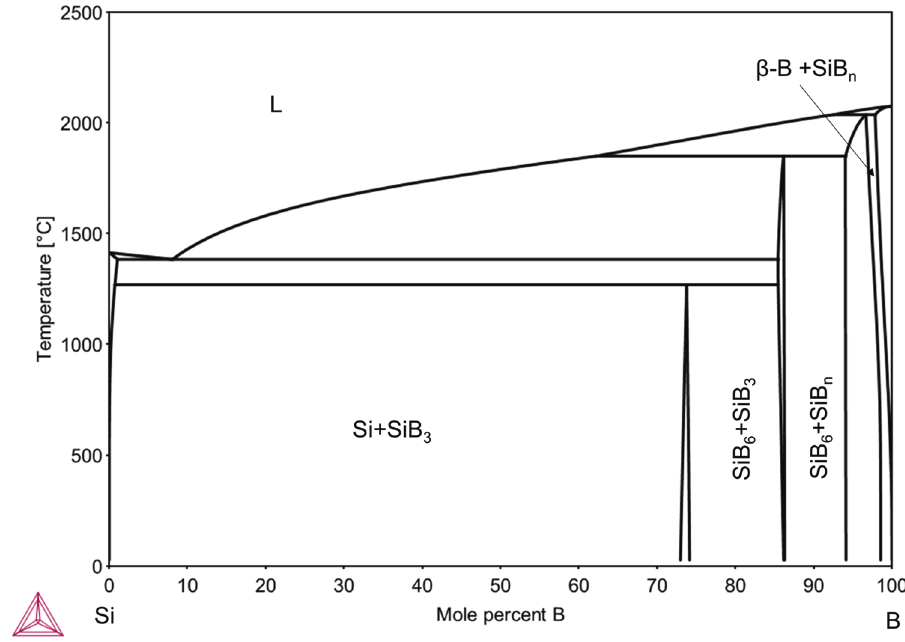
Figure 2: Si-B phase diagram [22].